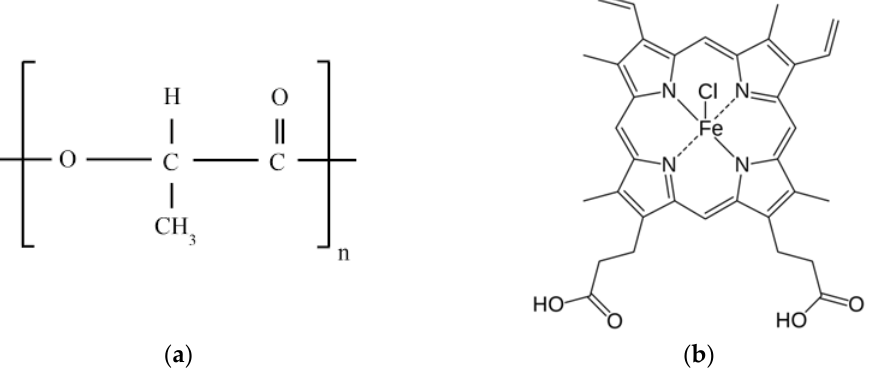
Figure 1. Structural formulas of PHB ( a ) and hemin ( b ).